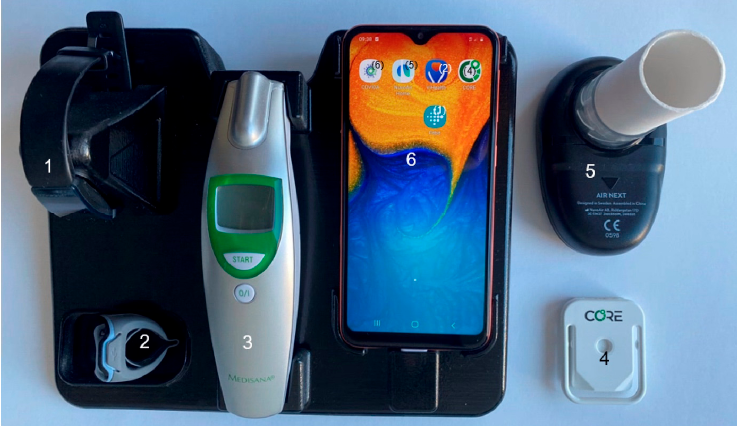
Figure 2. The COVIDA desk setup for the usability study contains a collection of sensors and monitoring modalities. Items in the picture are numbered and explained: (1) Wrist-worn accelerometer and heart rate sensor on magnetic charging interface; (2) finger ring pulse oximeter for continuous measurement of heart rate and oxygenation saturation; (3) infrared thermometer for forehead temperature measurement; (4) continuous core body temperature measurement device; (5) spirometer with mouthpiece for measurement of lung function; and (6) smartphone with daily questionnaire in the COVIDA app. The respective applications on the smartphone screen are indicated in brackets.